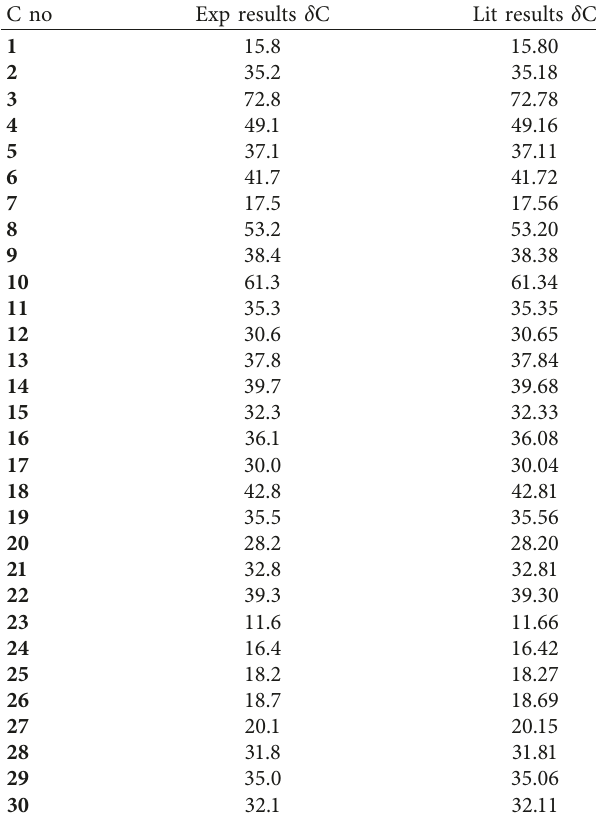
the literature for epifriedelanol (CDCl 3, δ in